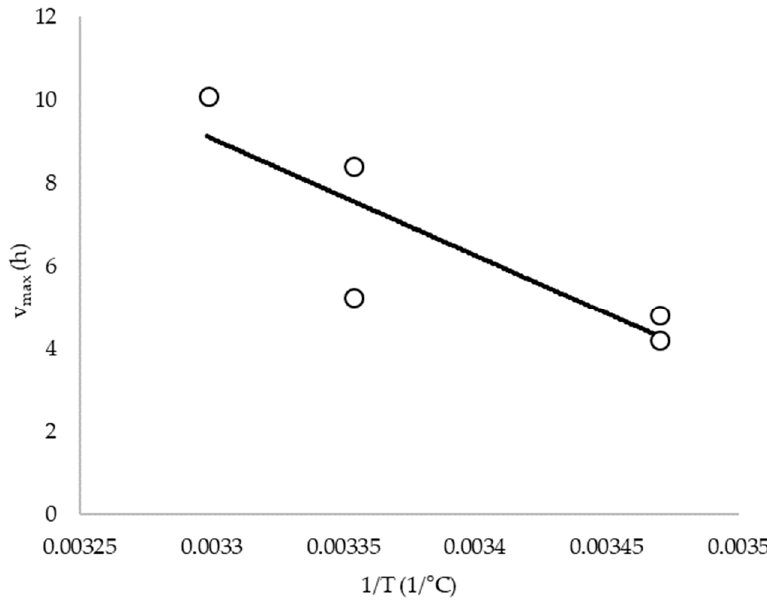
Figure 10. Effect of temperature on the kinetics of COD degradation at TOC 0 = 1400 mg/L and pH = 7.